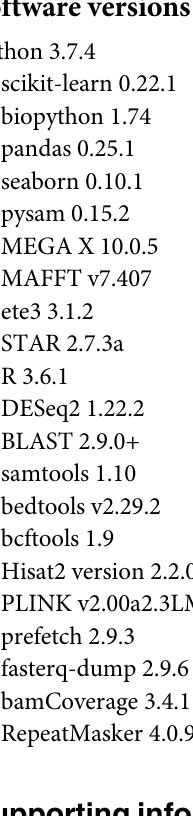
S2 Fig. Read depth of STLV-1, HIV-1, and chum salmon reovirus. Depth of reads mapping to Y-axis show the genome position of indicated virus and the depth of reads mapping to the indicated virus, respectively. The name of each dataset is shown at the top of the